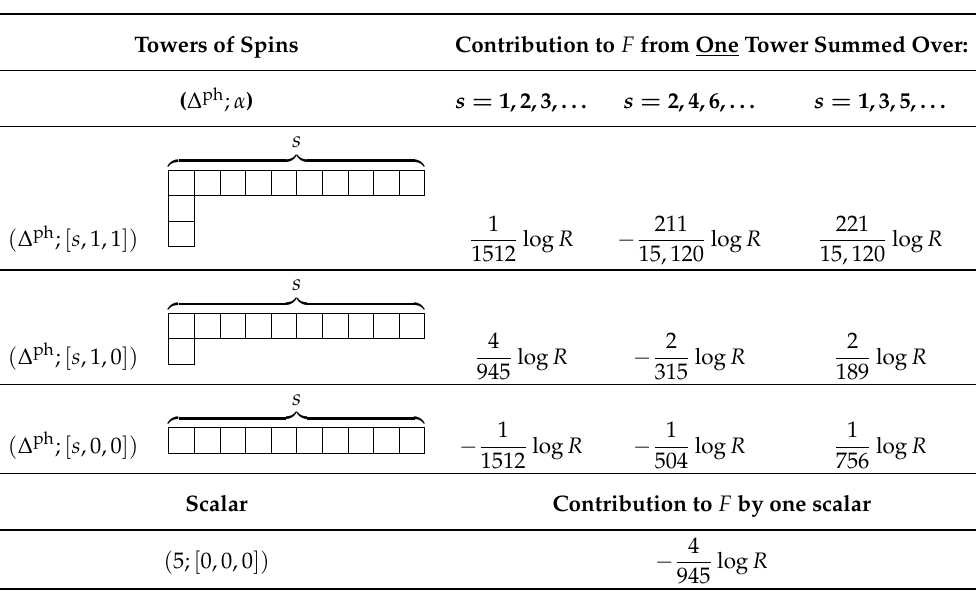
Table A4. Results for Type B theory in AdS 7 .